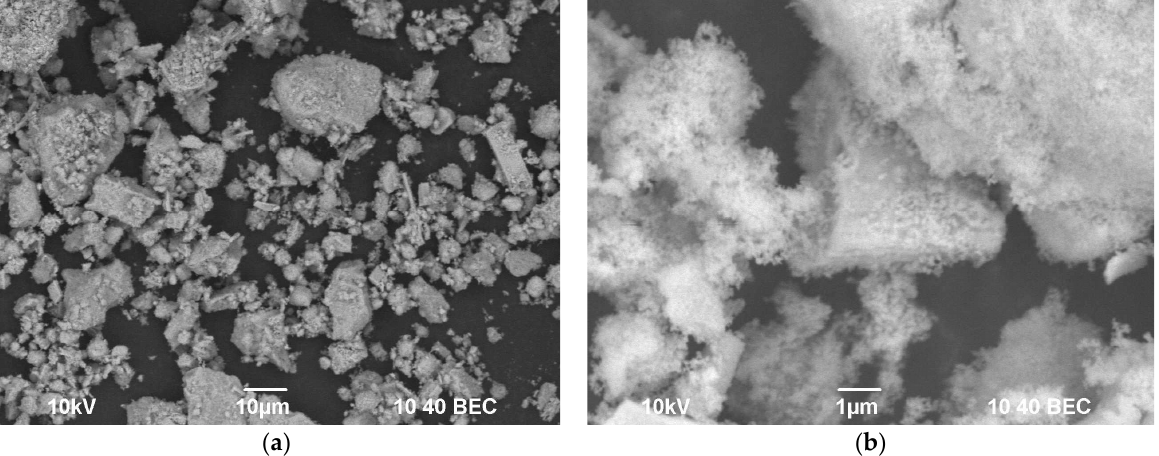
Figure 3. SEM images of YPO 4 :Gd powder ( a , b ). ( a , b ) present different images of the same powder at different magnifications.